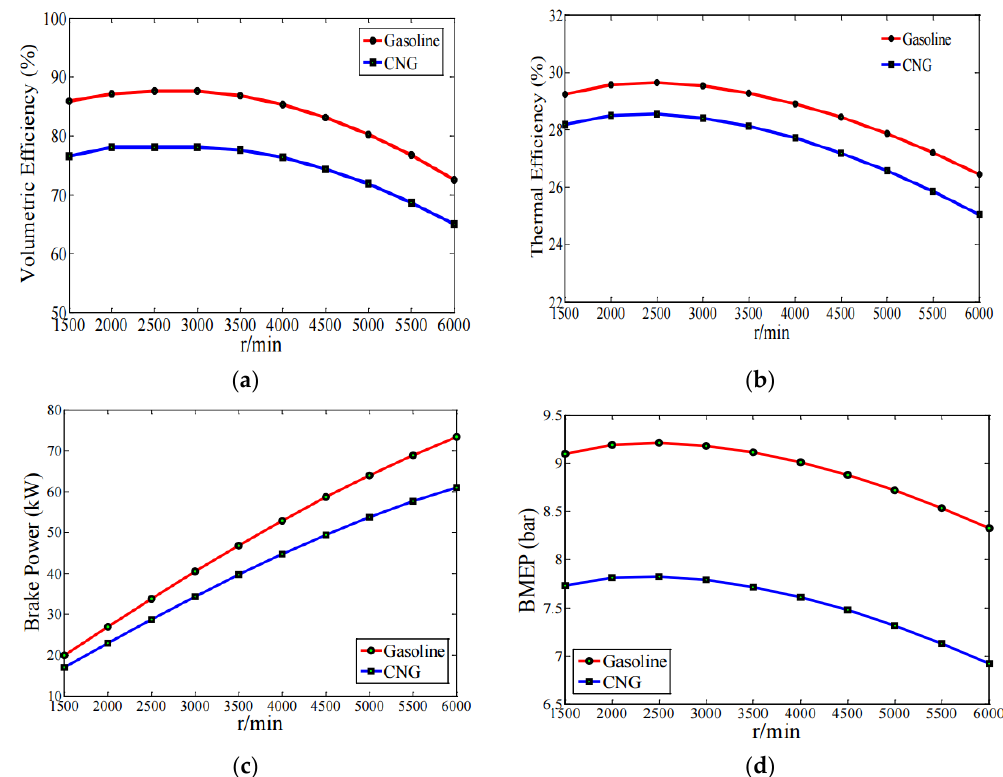
Figure 8. Performance comparison of CNG and gasoline in a retrofitted dual-fuel gasoline engine: ( a ) volumetric efficiency; ( b ) thermal efficiency; ( c ) brake power; ( d ) brake mean effective pressure (BMEP) [166].